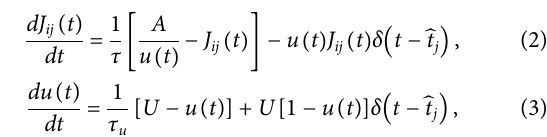
Frontiers in Physics |